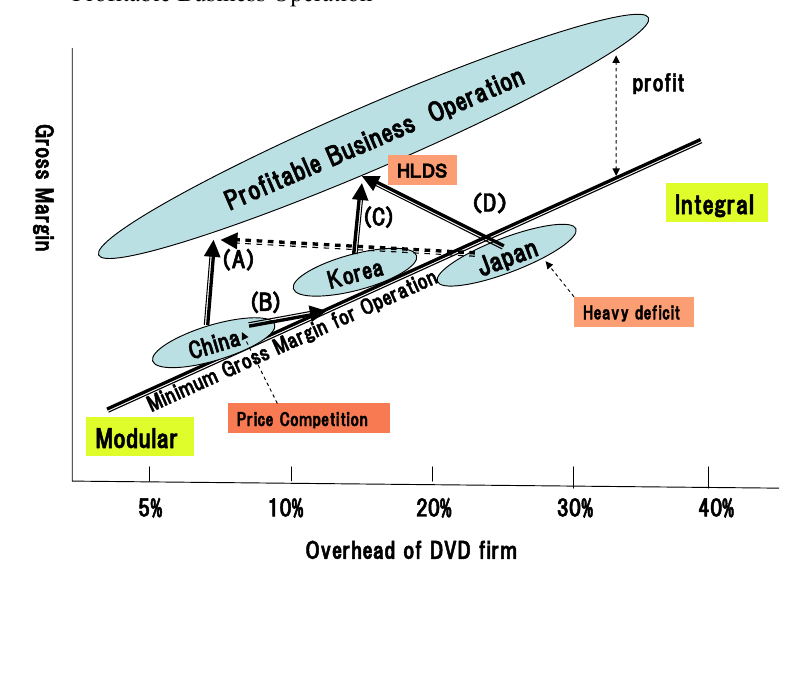
Figure 12. Overhead-position of China/Taiwan, Korea, Japan and Direction of Profitable Business